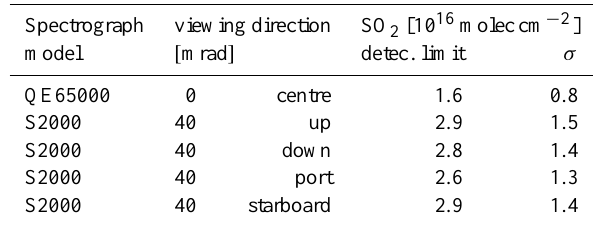
Fig. 2. A schematic of the different airborne viewing directions. All telescopes were mounted at the airplane close to co-pilots window. The viewing directions (up, down, starboard, port) were looking at angles of 40 mrad with respect to centre and a horizontal plane (up, down) or a vertical plane (starboard, port). Table 1. Spectrographs used for airborne measurements, their re- spective viewing direction in mrad from centre and detection limits (95%=2 × σ ). σ is the mean error of all measurements with dis- tance greater than 10km to the plume of approaches III–V for the respective